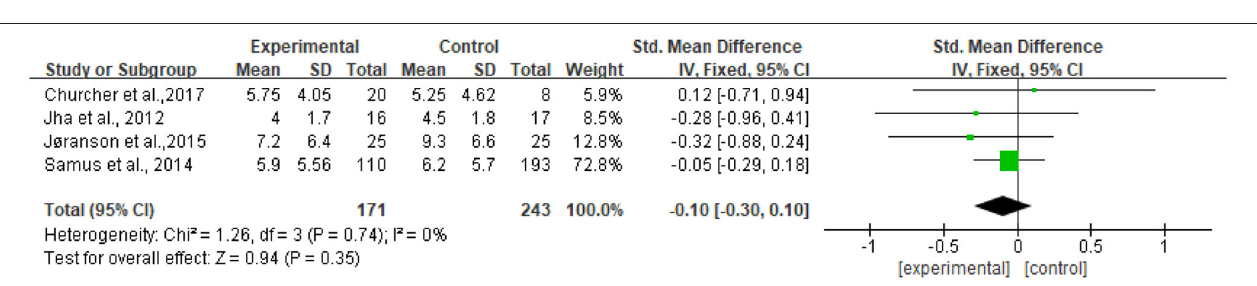
FIGURE 7 | Subgroup analyses of the intervention group vs. the control group on CSDD.